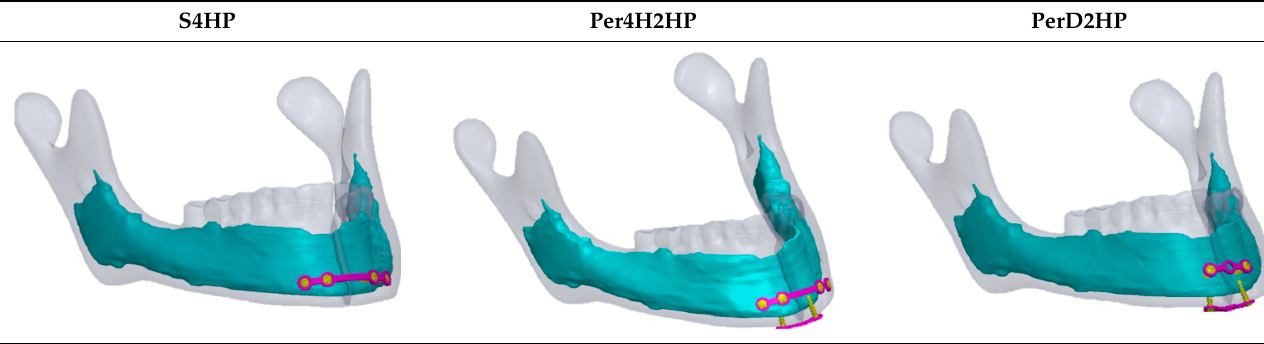
Table 1. Schematic of solid models used in this study. S4HP: a centrally extended single four-hole plate fixed on the mandibular anterior lower border; Per4H2HP: perpendicularly oriented S4HP fixed on the mandibular anterior lower border and 2HP fixed on the mandibular inferior border; PerD2HP: perpendicularly oriented 2HP fixed on the mandibular anterior lower border and the other 2HP fixed on the mandibular inferior border.